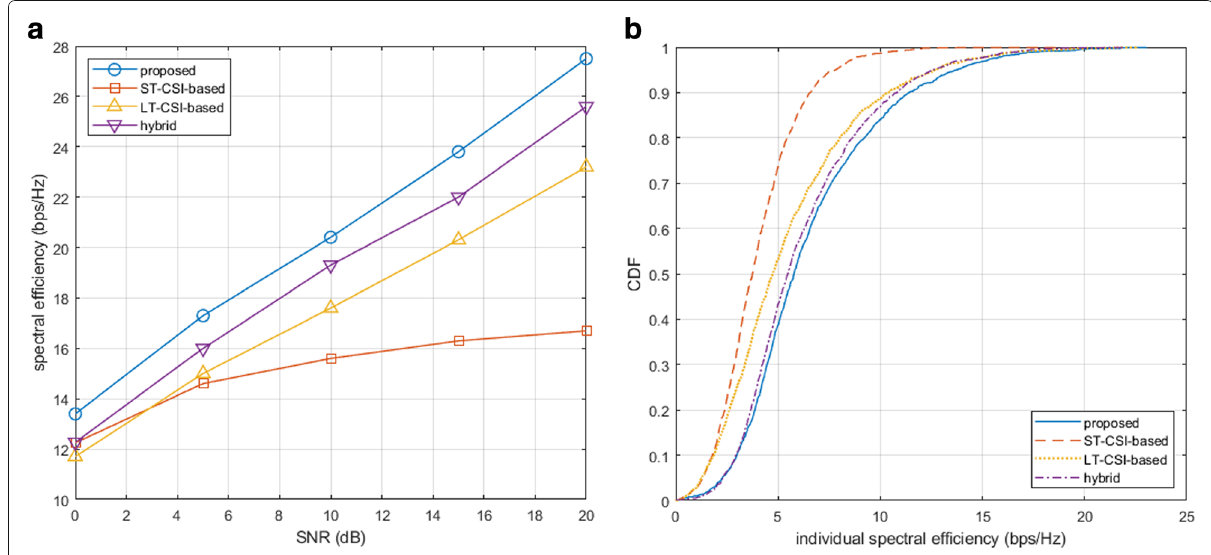
Fig. 4 Spectral efficiency in fixed velocity. a Spectral efficiency. b Empirical CDF of spectral efficiency B k ,2 with ρ k = 1 and B k ,1 with ρ k = 0 in